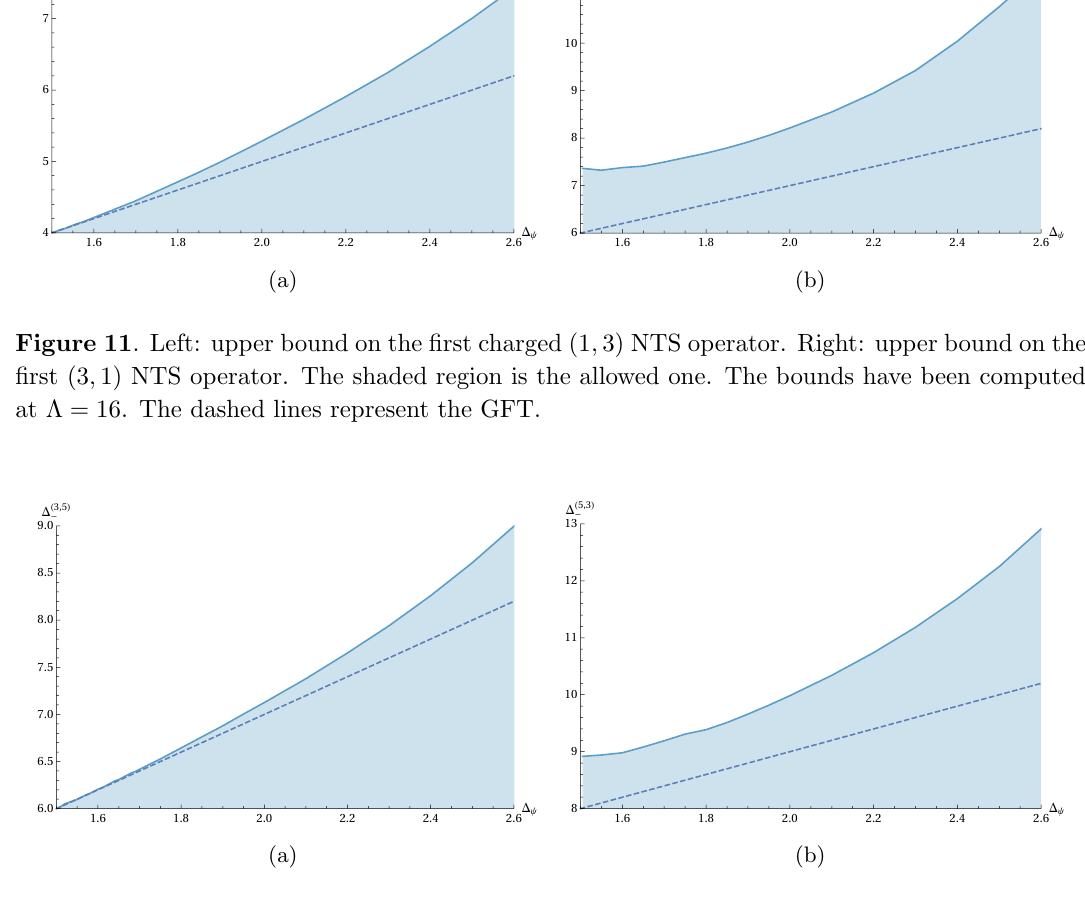
Figure 12 . Left: upper bound on the (cid:12)rst charged (3 ; 5) NTS operator. Right: upper bound on the (cid:12)rst (5 ; 3) NTS operator. The shaded region is the allowed one. The bounds have been computed at (cid:3) = 16. The dashed lines represent the